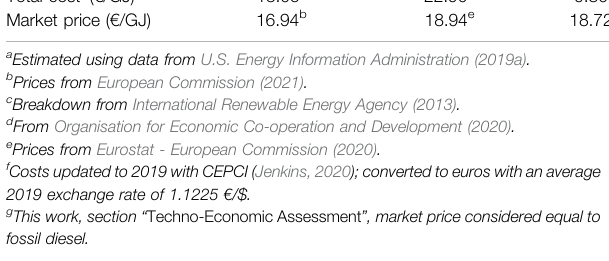
TABLE 4 | Production cost breakdown of gasoline and alternatives. Densities and Lower Heating Values used are shown in Table 1 . Fossil gasoline CAPEX ( € /GJ)